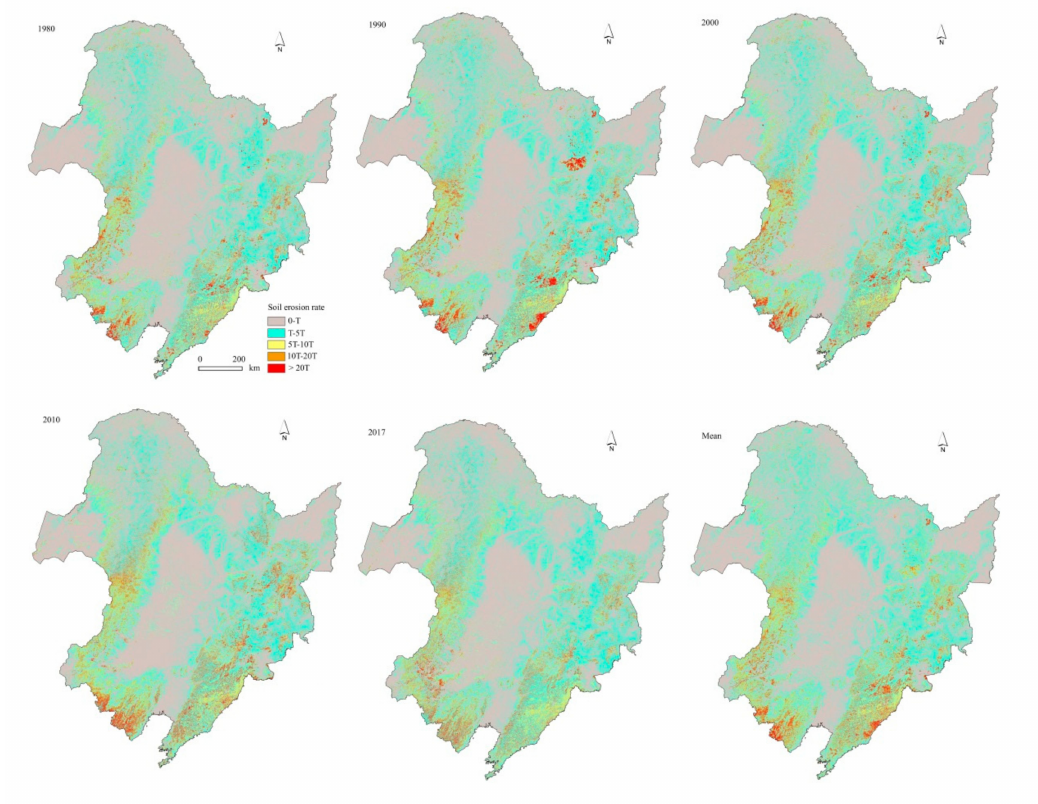
Figure 5. The spatial distribution characteristics of soil erosion rates in NEC in 1980, 1990, 2000, 2010, 2017, and their average in